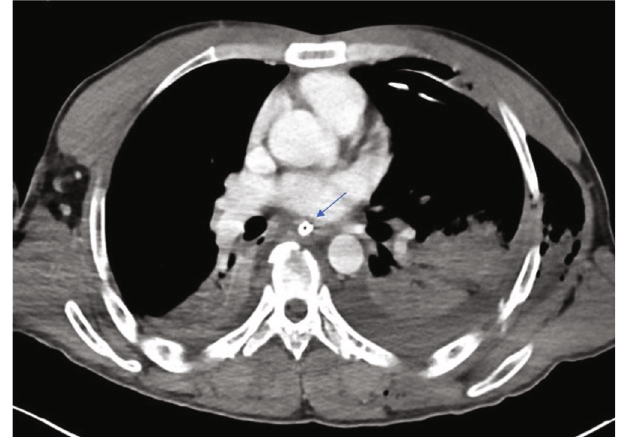
Figure 1: Chest CT scan showing orogastric tube